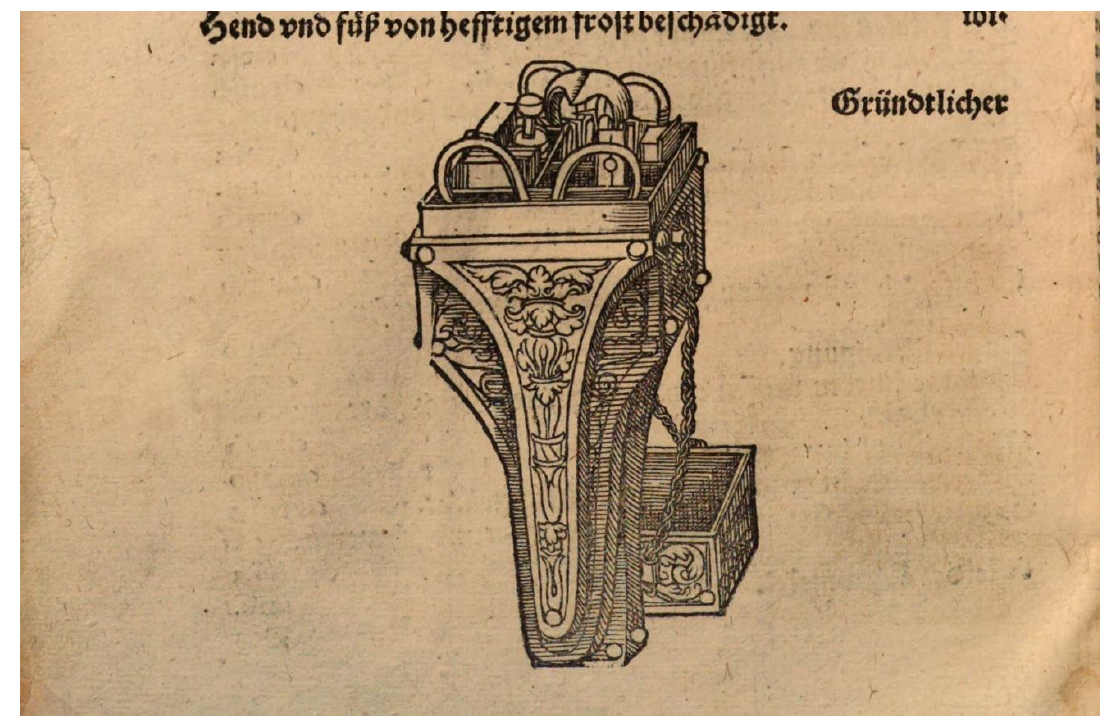
Figure 6. A surgical instrument case with the lid detached, showing the contents. Walther Hermann Ryff, Groß Chirurgei: oder volkommene Wurdartznei (Frankfurt am Main: Egenolff 1559) p. [xii]. Munich, Bayerische Staatsbibliothek—Res/4 Chir. 110,1 .